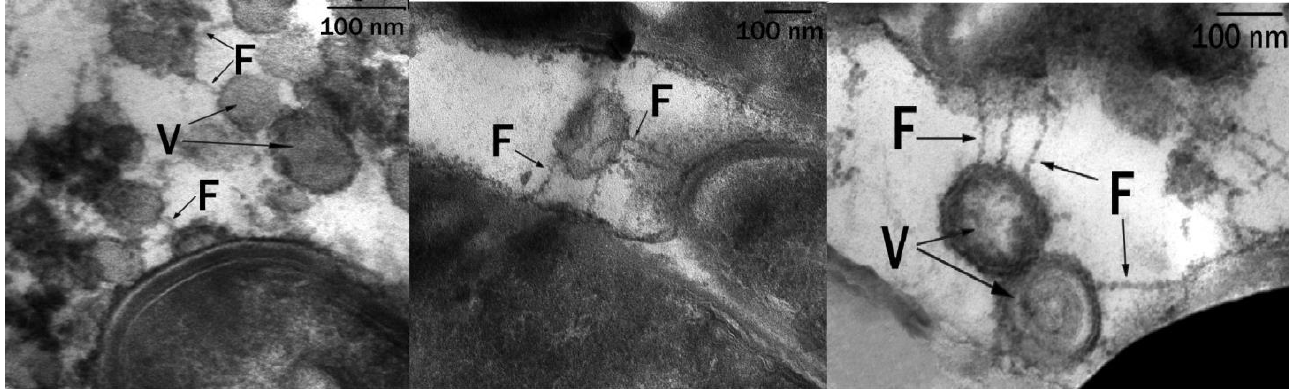
Figure 5. Ultrathin sections of R. erythropolis S67 cells (cultivation conditions: solid hexadecane, 10 °C, 6 days): Vesicles (V) are visible, surrounded by a shell of electron-dense layers, connected to bacterial cells by electron-dense fibers (F); 100 nm scale.